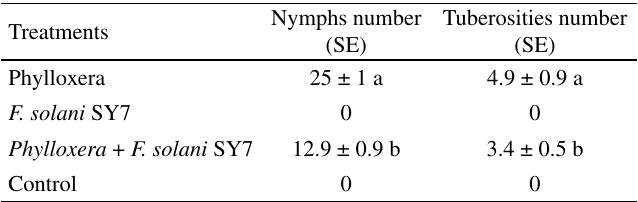
Table 3 - Effects of F. solani SY7 infection on numbers of nymphs and tuberosities